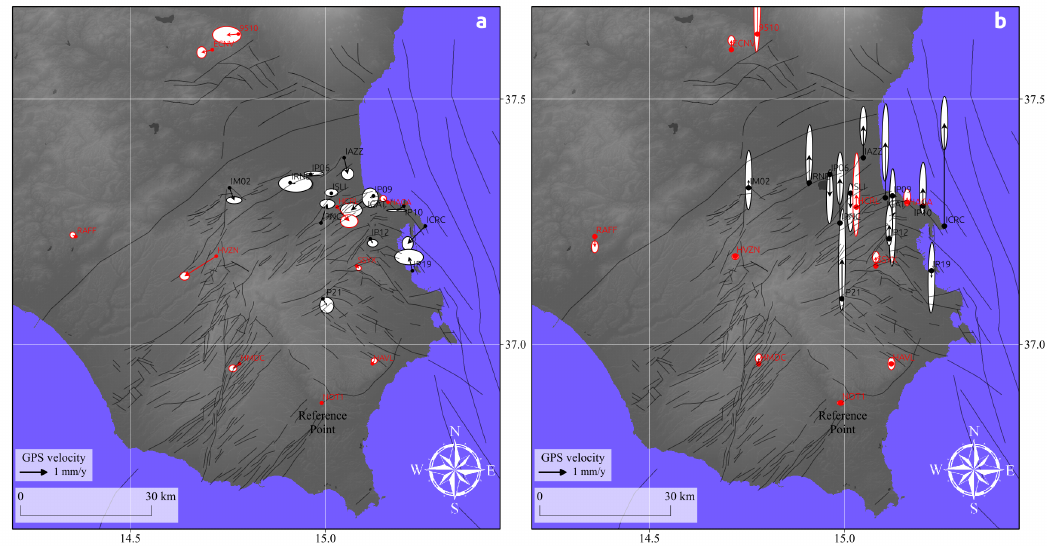
Figure 3. GPS velocity field: Horizontal ( a ) and vertical ( b ) velocities with respect to the NOTO reference station (NOTO). Black stations have been installed between 1993 and 1997, while red stations were installed after 2000. The velocity field was originally calculated by Angelica et al. 2013